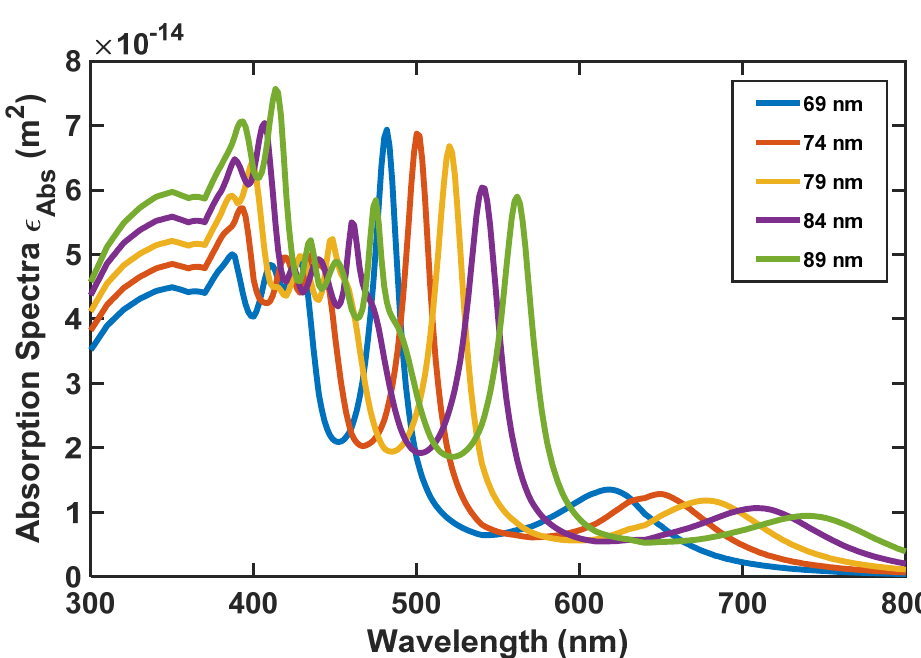
12 of 23 Figure 9. Probability density function (PDF) and cumulative distribution function (CDF) for emission spectrum of core-shell SiO 2 -silicon nanoparticle ( A , B ), respectively. If the photon is emitted from the nanoparticle, its new position is stored, and the previous steps are repeated. Finally, optical efficiency ( η opt ) is defined as the ratio of photons collected from F 2 and F 3 to all photons emitted by the LED (Equation (15)). 2